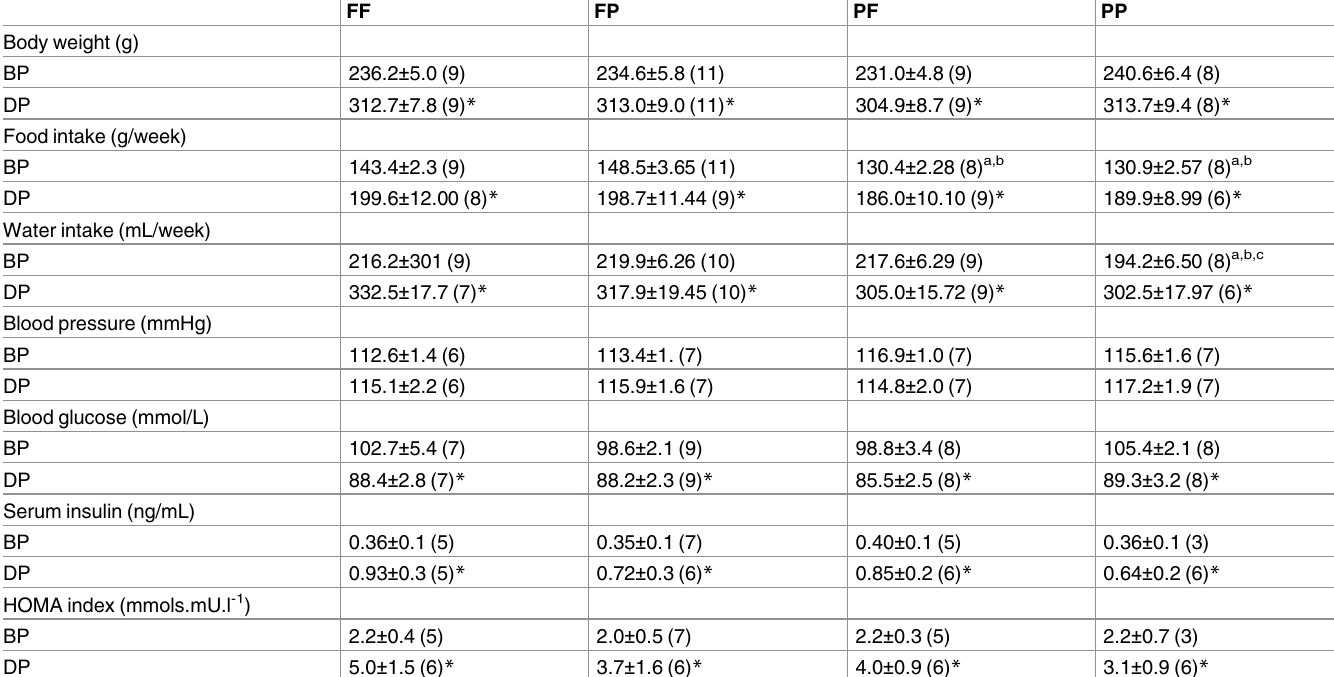
Table 3. Maternal parameters.